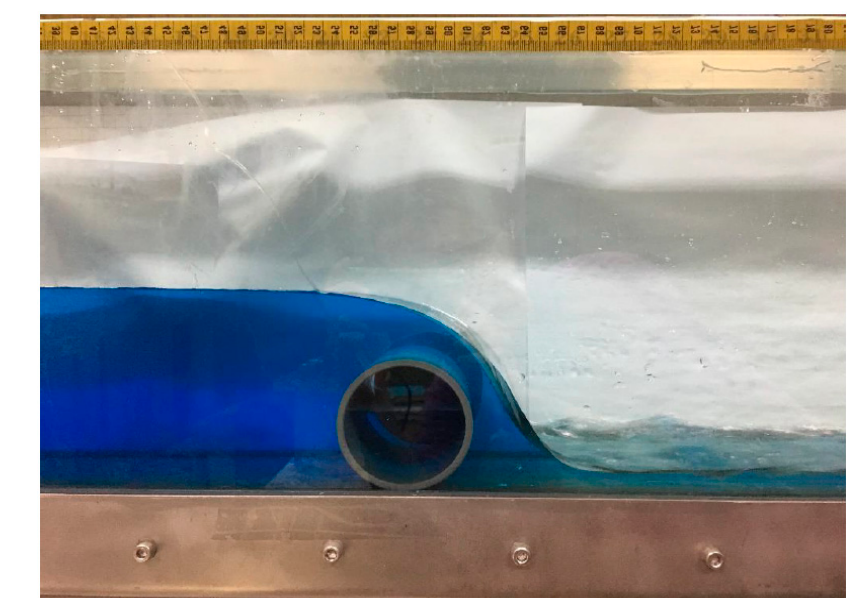
Figure 1. Schematic diagram of the circular dam and flow parameters.